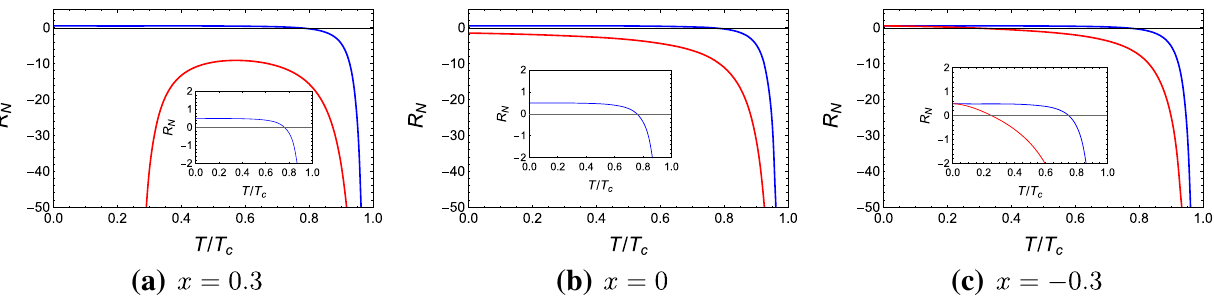
infinity at sufficiently low temperature. This behavior is consistent with that of Fig. 4a, where the saturated black hole curve asymptotically approaches to the spinodal curve (where the thermodynamic curvature R N diverges) at (cid:13) T = 3 /